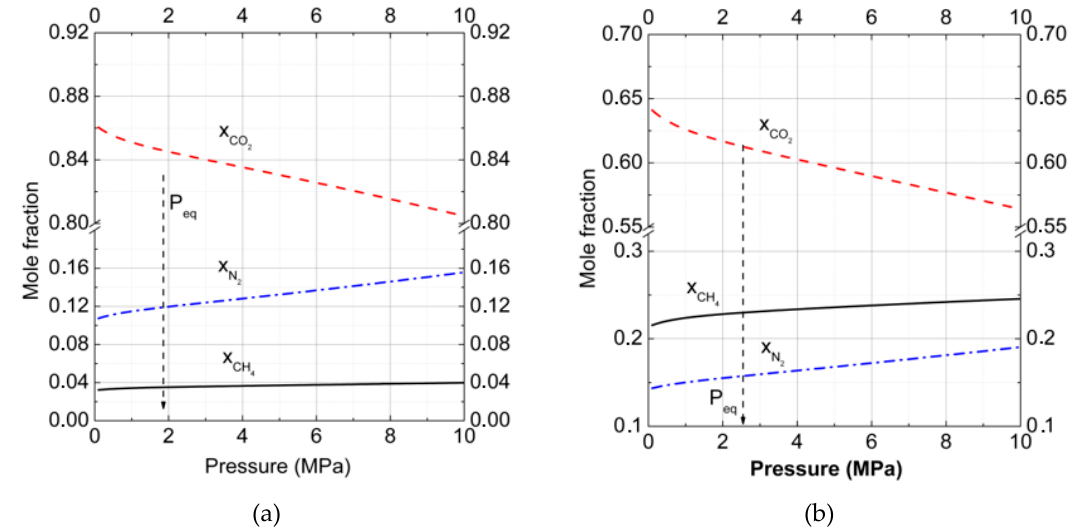
Figure 3. Mole fraction of carbon dioxide, methane, and nitrogen in ternary hydrate phases at T = 273 K. The gas phase consisted of ( a ) carbon dioxide (27%) and methane (3%) with nitrogen (70%), and ( b ) carbon dioxide (15%), methane (15%), and nitrogen (70%) ( x N = dash-dotted lines). The total number of calculated points was equal to 100 with a pressure step of 0.1 MPa for each